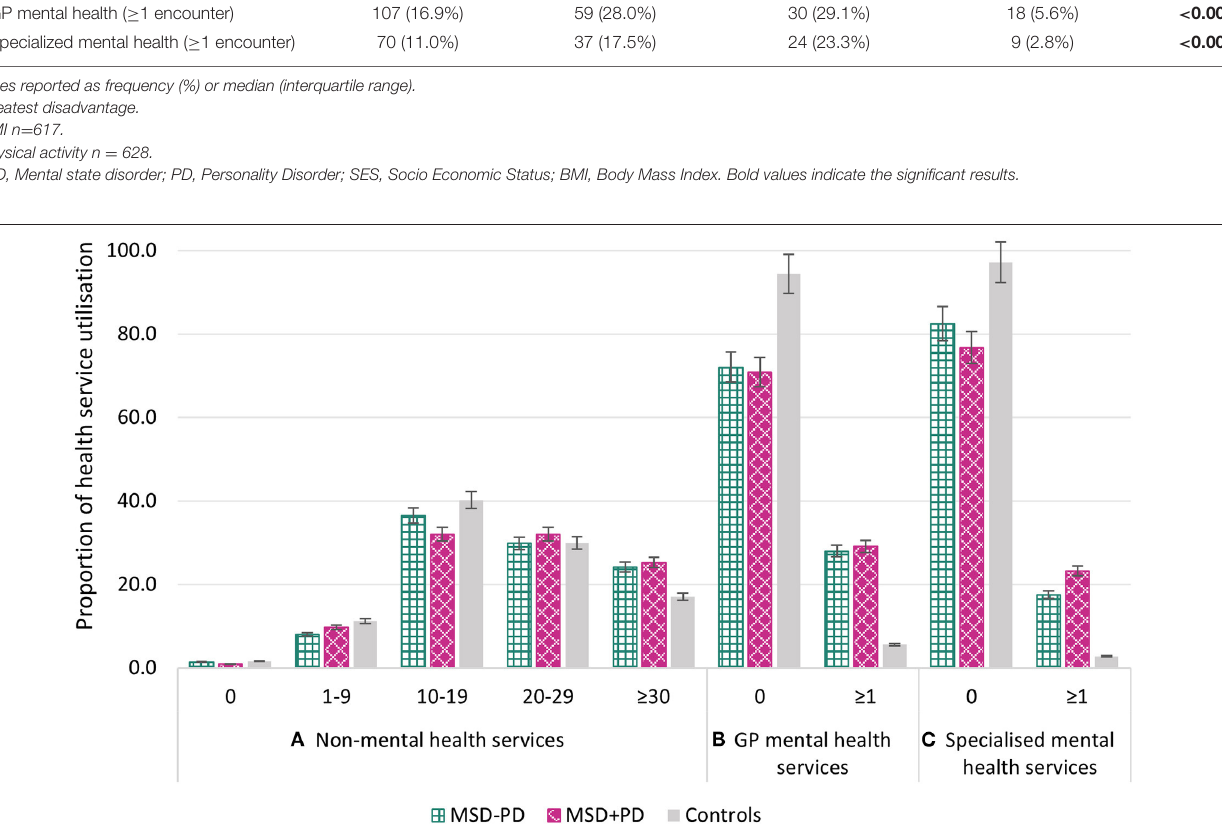
FIGURE 1 | (A–C) Proportion of health service utilization by its type and across the sample. MSD, Mental state disorder; PD, Personality